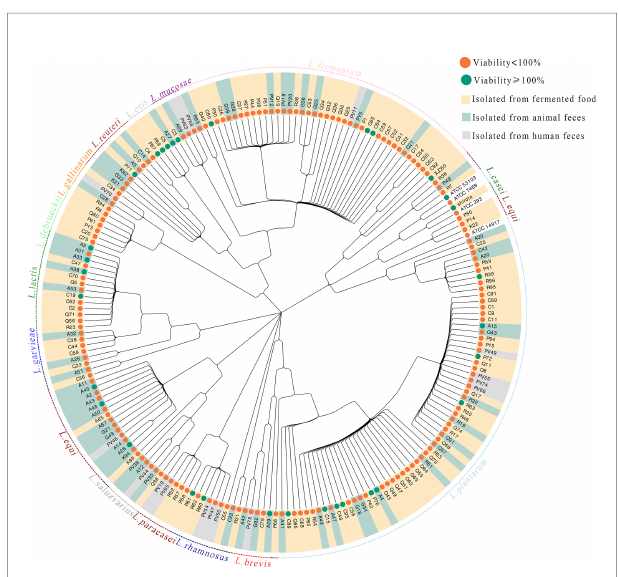
FIGURE 1 | Evolutionary tree of the lactic acid bacteria (LAB) isolates and their abilities to repair UVB damage The evolutionary tree was built according to the 16S rRNA gene sequences of 206 strains of LAB. The taxonomy of each LAB strain is shown in the outer circle of the tree, and isolation information for each LAB strain is indicated by the bar color. The antiphotoaging potential (cell viability protection) for each strain is indicated using a green or orange